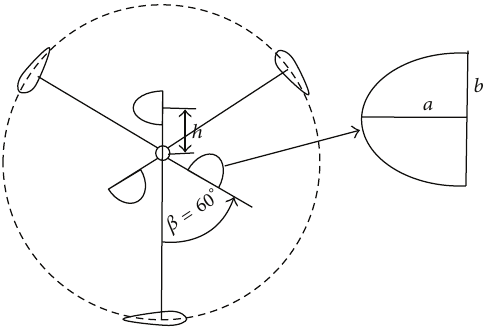
Figure 1: Combined Darrieus-Savonius